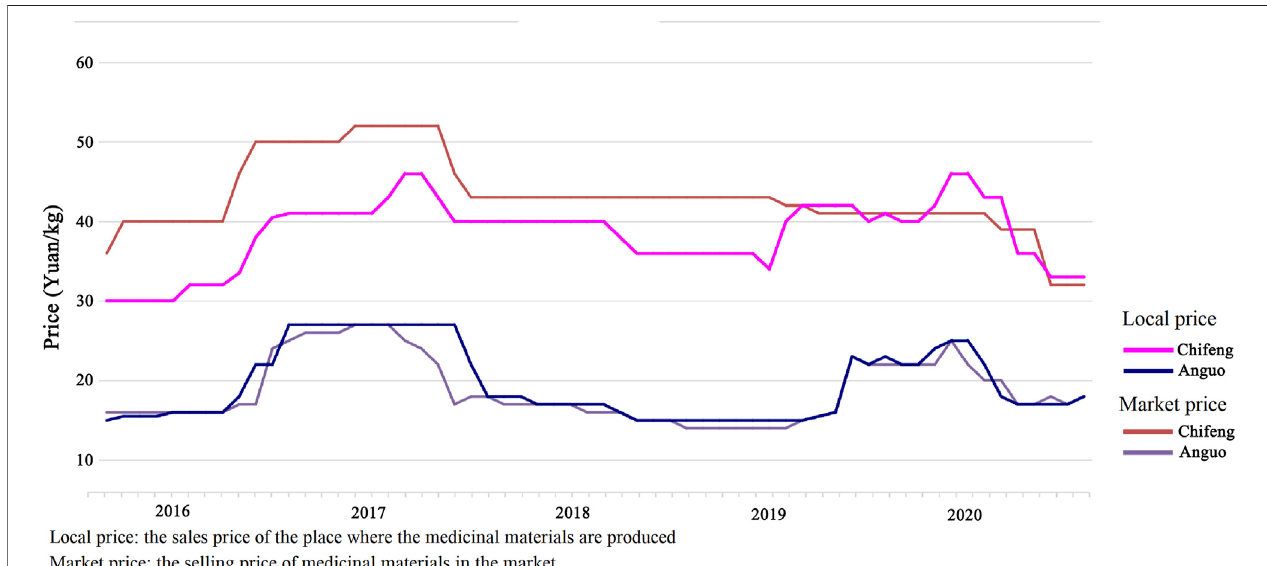
FIGURE 6 | Price details of two regional